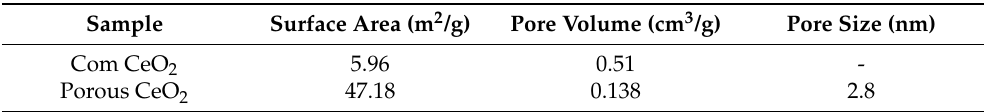
Table 1. The textural properties of the porous ceria compared with that of commercial ceria, as obtained from N 2 sorption measurements.